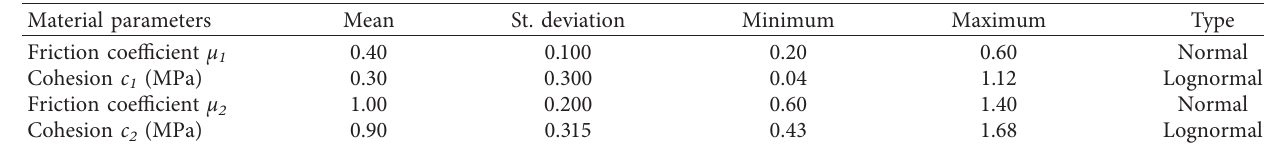
Figure 3: Sensitivity of IDA curves to friction coefficients. (a) μ 1 affects the shearing slide of the starting point on the main sliding surface. (b) Minor effect of μ 1 on the shearing slide of the ending point on the auxiliary sliding surface. (c) μ 2 obviously affects the shearing slide of the starting point on the main sliding surface. (d) Distinct impact of μ 2 on the shearing slide of the ending point on the auxiliary sliding surface. Table 2: The probability distributions for the random